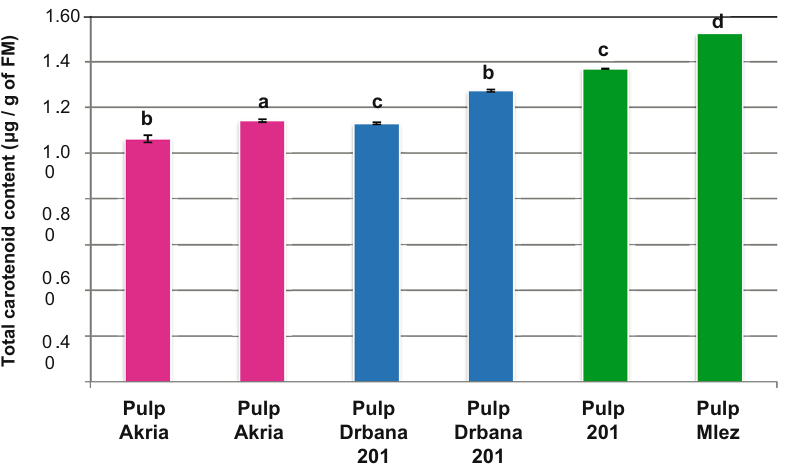
Figure 6: Total carotenoid content of the fruit pulp of Barbary fi g varieties ( Akria, Drbana, and Mlez ) of both 2015 and 2016 crop years. Mean values with the same letter did not reveal a signi fi cant di ff erence at p <